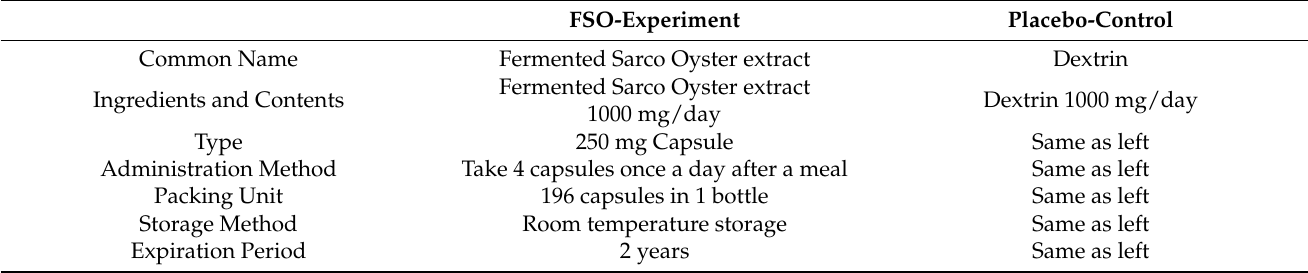
Table 1. Ingredients and formulation of the test supplement and placebo supplement. FSO-Experiment